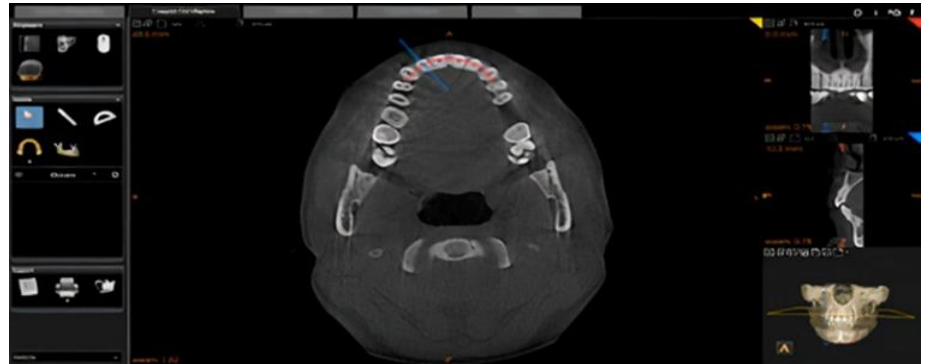
Fig. 1. Axial view at the maxillary arch. The red line indicates the curvature of the alveolar ridge. The blue line, perpendicular to the alveolar ridge, indicates where the cross-sectional view was taken.